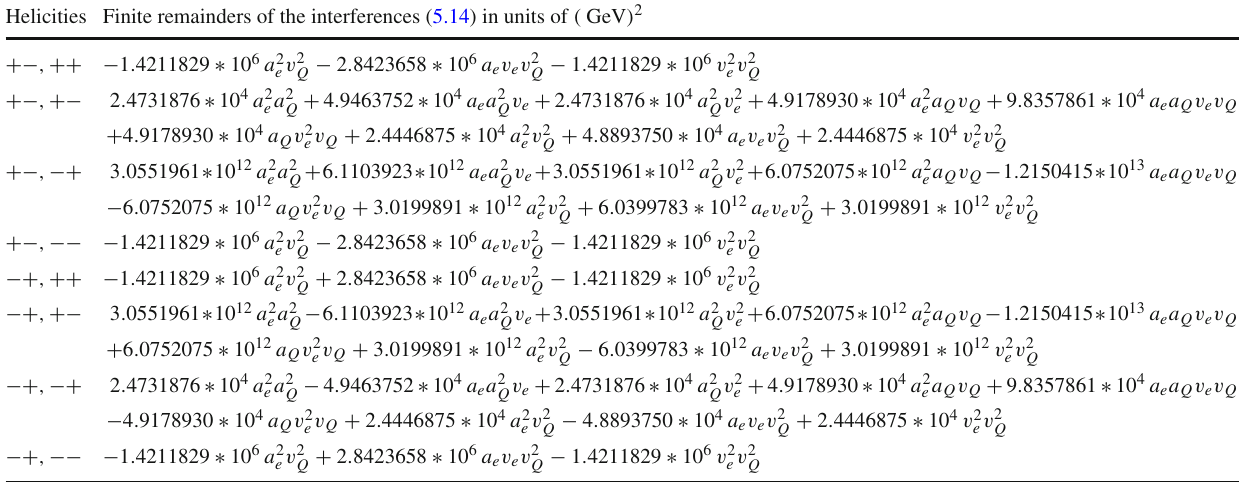
Table 1 Numerical values of the finite remainders of the interferences (5.14) at the test point m = 17 . 3 GeV, s = 10 6 ( GeV ) 2 , t = − 90 ( GeV ) 2 Helicities Finite remainders of the interferences (5.14) in units of ( GeV )